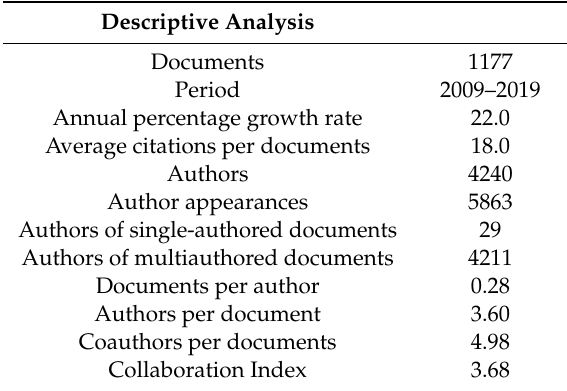
Table 1. Descriptive analysis of retrieved